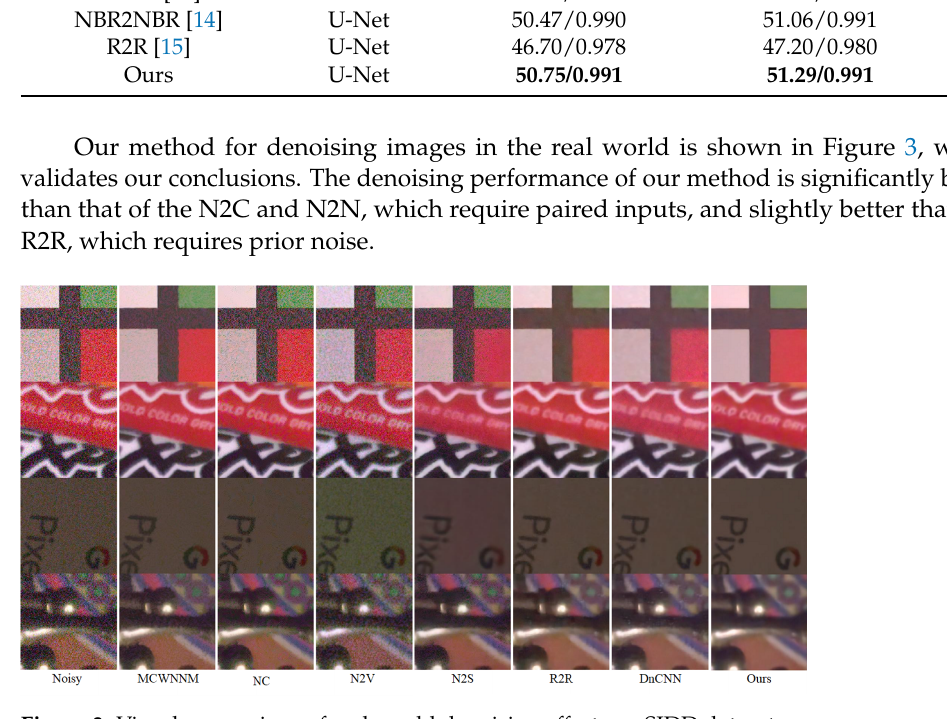
Figure 3. Visual comparison of real-world denoising effects on SIDD